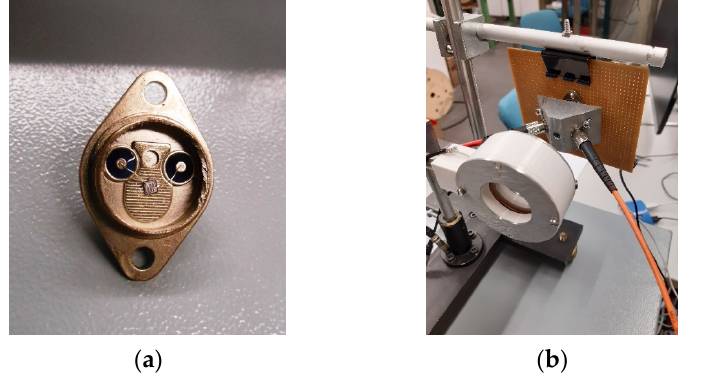
Figure 9. ( a ) The top side of the transistor is removed to expose its sensitive part to the beam. ( b ) Picture of the experimental apparatus for the irradiation of the 2N3055 transistor.